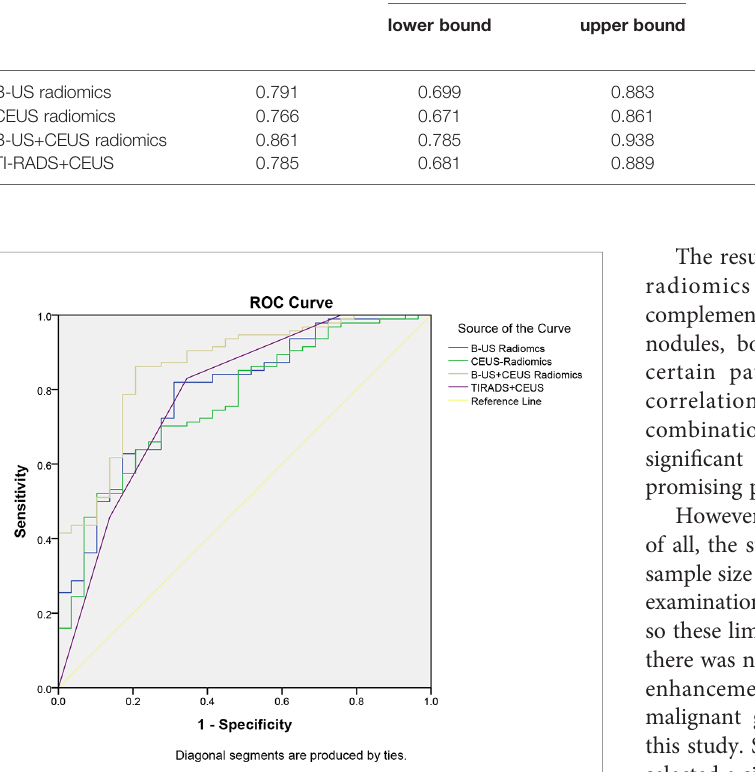
TABLE 6 | Comparison of the AUCs of four types of models.